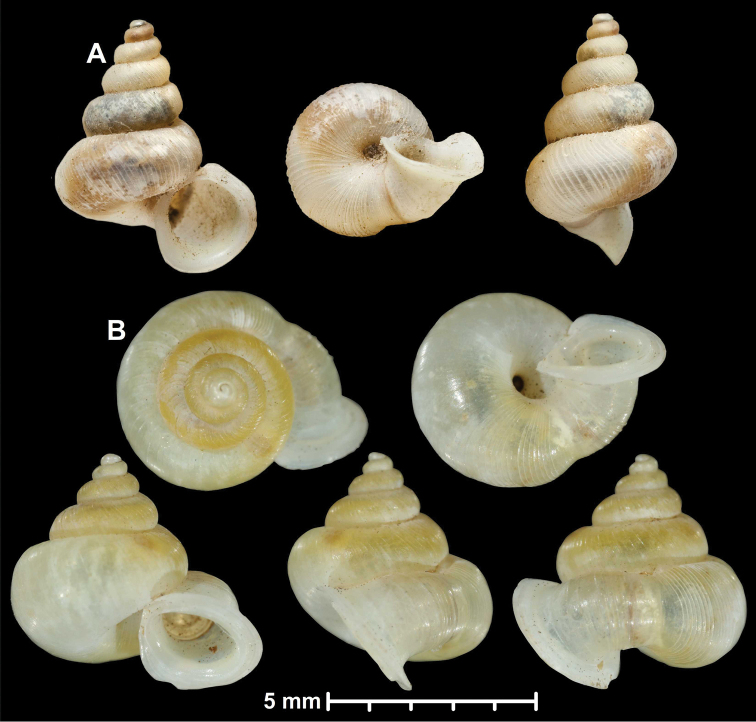
Shells of Stomacosmethis Bollinger, 1918 species AStomacosmethis
congener (E. A. Smith, 1895), syntype (NHMUK 1892.7.20.30–32) BStomacosmethis
dohrni (O. Boettger, 1893), lectotype (SMF 109278). Figures: Barna Páll-Gergely, courtesy Ronald Janssen (B) and Harold Taylor (A).